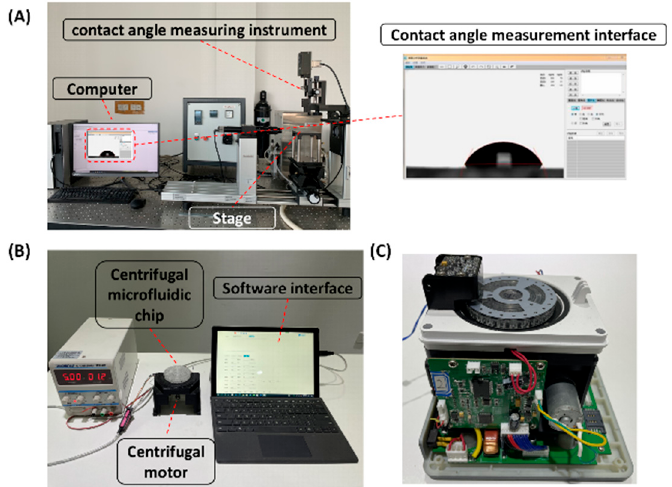
Figure 3. Experimental equipment: ( A ) contact angle test; ( B ) liquid transfer efficiency test; ( C ) centrifugal microfluidic immunoassay prototype.